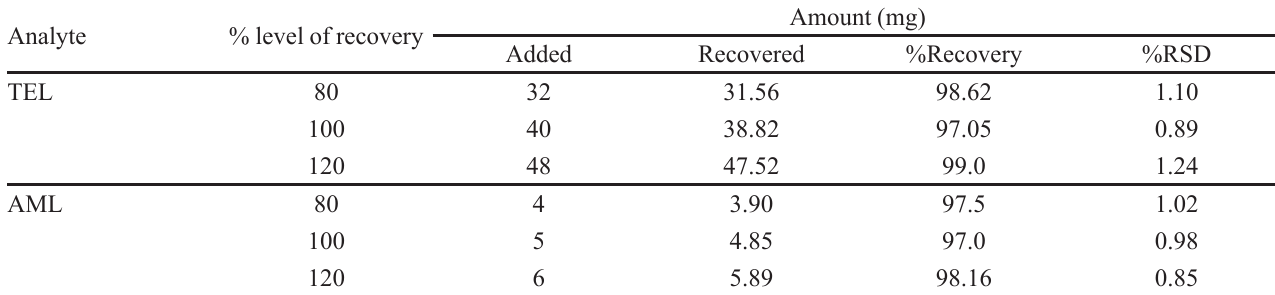
TABLE V - Results for accuracy for the proposed dissolution method